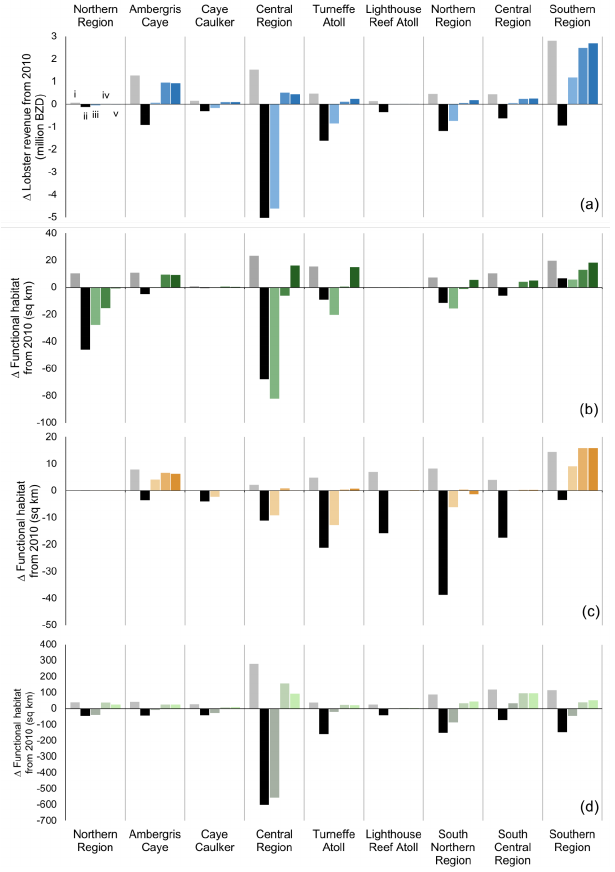
Fig. 3 . Difference, relative to 2010 levels, in lobster revenue and mangrove, coral, and seagrass functional habitat in Belize under the conservation scenario (gray), development scenario (black), and three iterations of the informed management scenario for August 2012, November 2012, and August 2013 (light to dark